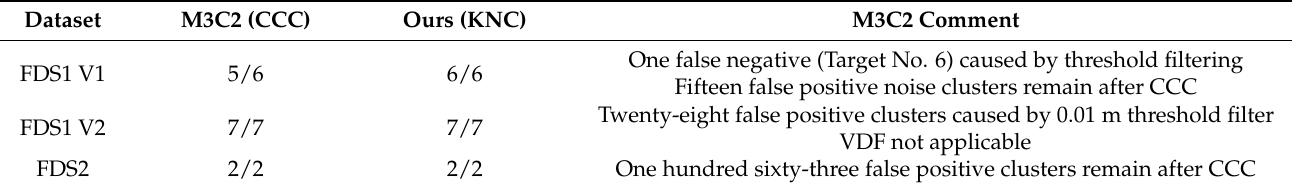
Table 3. Number of targets detected by M3C2 and our method.